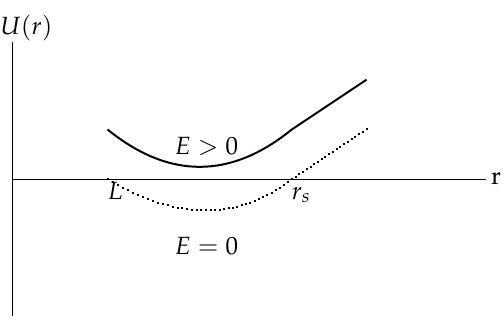
Figure 6. The effective potential U(r) for a tachyon impacting a black